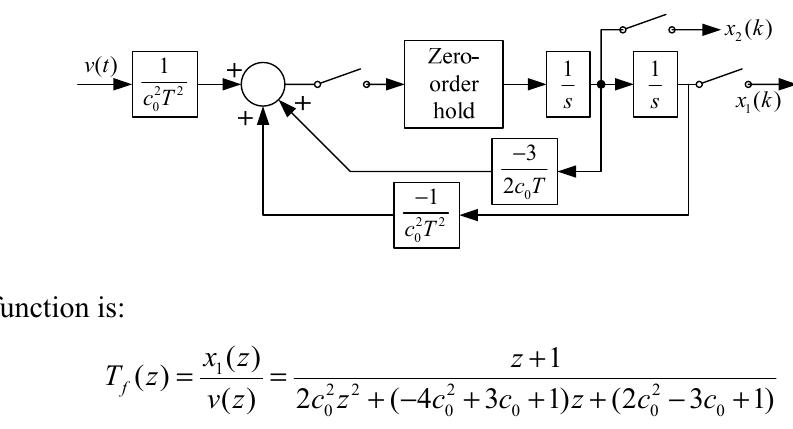
Figure 10. Block diagram of Equation